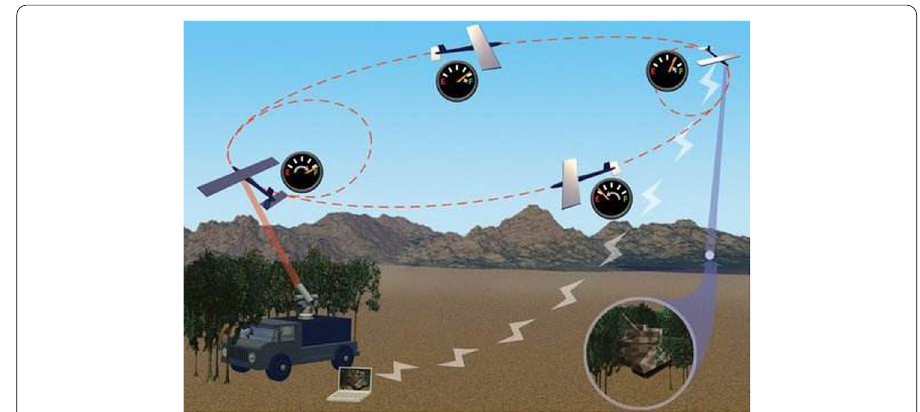
Fig. 1 Vehicle-mounted laser wireless power transmission